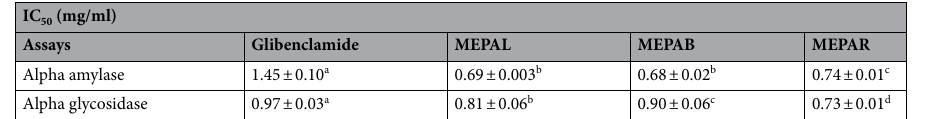
Table 5. IC 50 value of P. americana extracts on alpha-amylase and alpha-glycosidase activity. Values represent mean ± standard deviation of replicate readings. Where MEPAL methanol extract of P. americana leave, MEPAR methanol extract of P. americana root, MEPAB methanol extract of P. americana stem bark. Values with different superscripts (a,b,c,d) along the same row are significantly different from one another (P < 0.05).